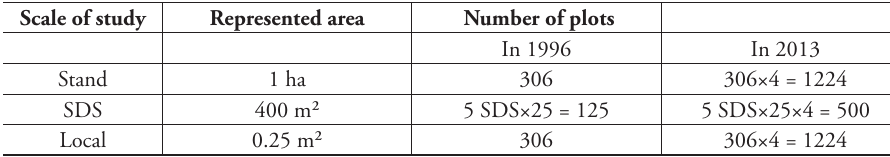
Table 2. Summary information on spatial scales and number of sampling units used in this study (SDS = stand developmental